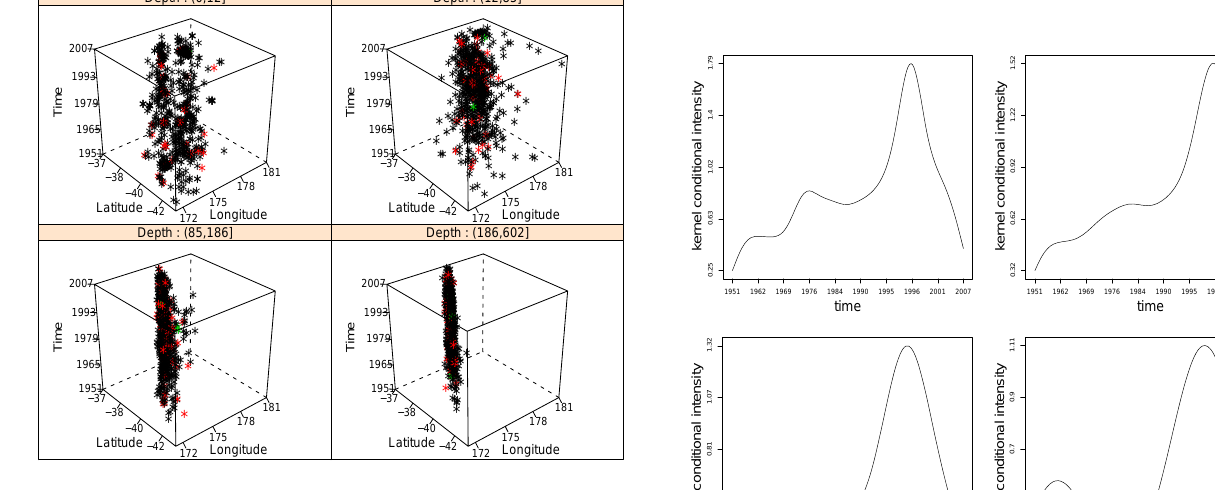
Fig. 2. 3-D scatterplot of earthquakes epicenters in terms of latitude, longitude and time. Depth is used as the conditioning variable. Dif- ferent colors are used for different ranges of magnitude: black for 4 . 5 ≤ M < 5 . 4, red for 5 . 4 ≤ M < 6 . 3 and green for 6 . 3 ≤ M < 7 . 2.